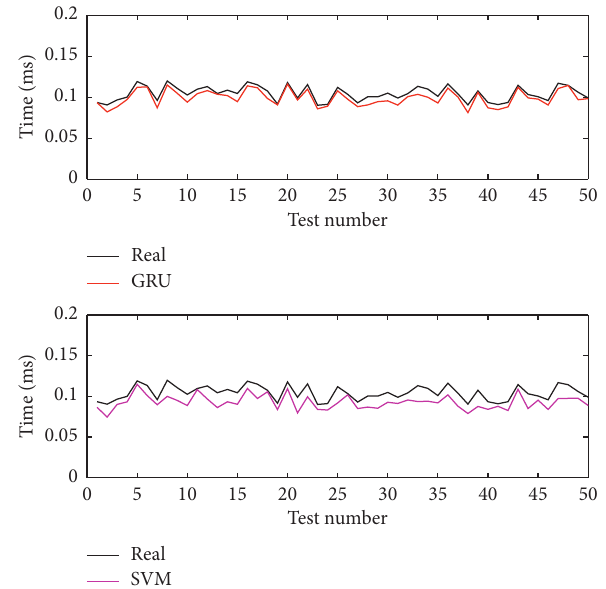
Figure 7: Simulation results compared with the SVM algorithm.